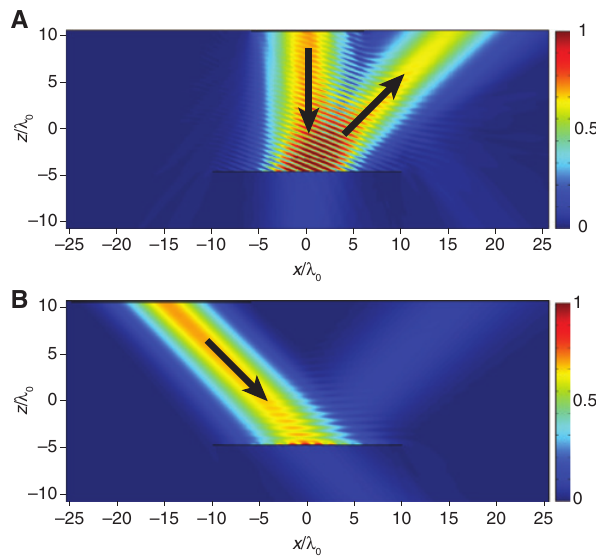
Figure 5: Eight-parameter metasurface simulations: COMSOL simulated normalized absolute value of the total electric field corresponding to (A) the transformation in Figure 4A and (B) the transformation in Figure